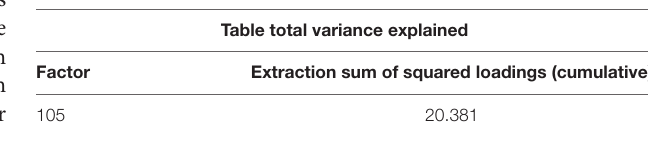
TABLE 11 | Test for common method variance. Table total variance